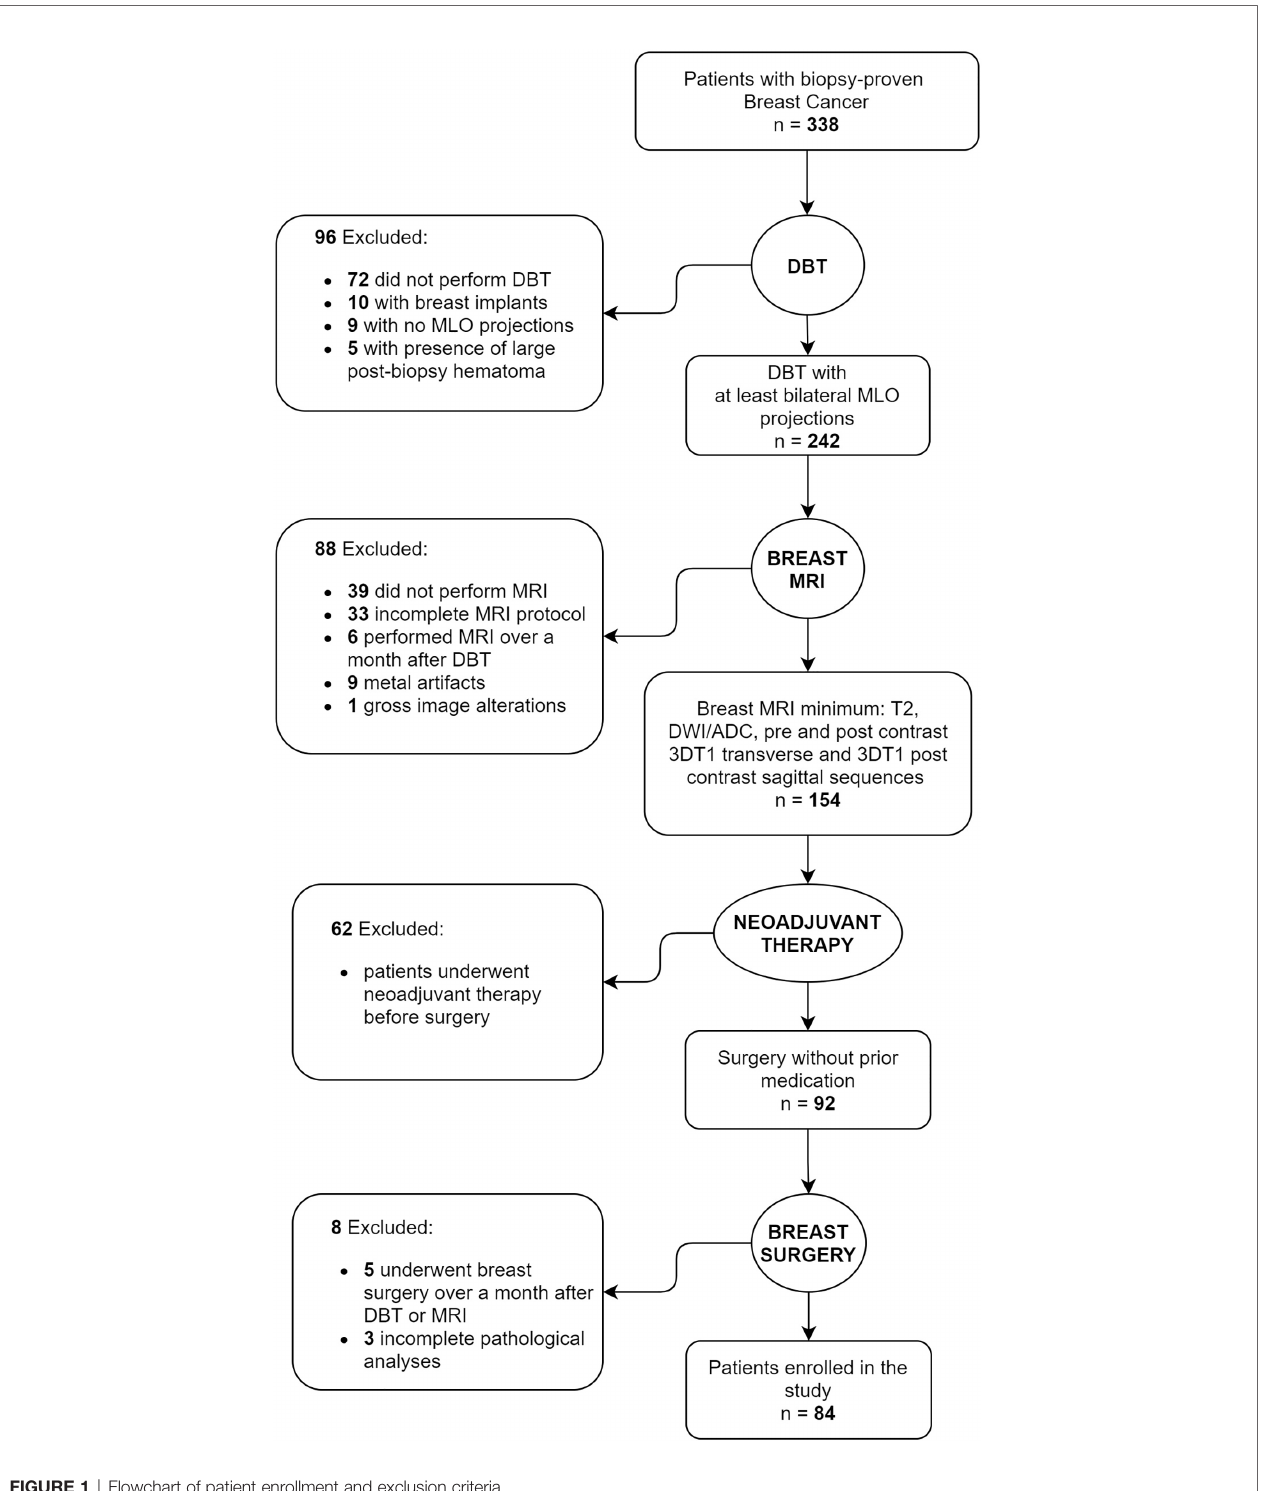
FIGURE 1 | Flowchart of patient enrollment and exclusion